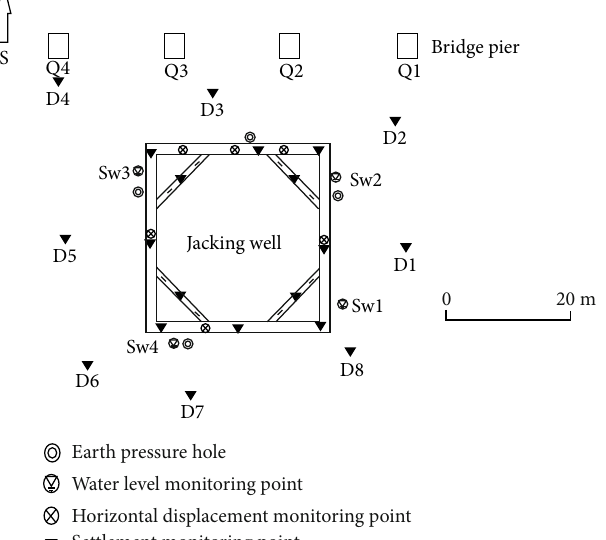
Figure 2: Di ff erent forms of monitoring